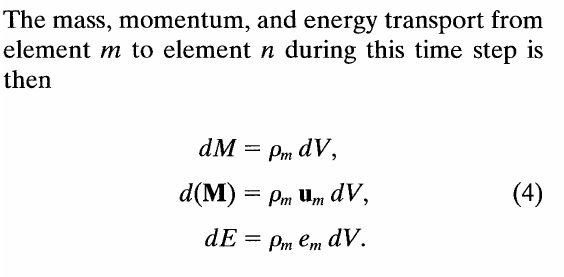
FIGURE 1 Problem geometry for the spherical bub ble problem.